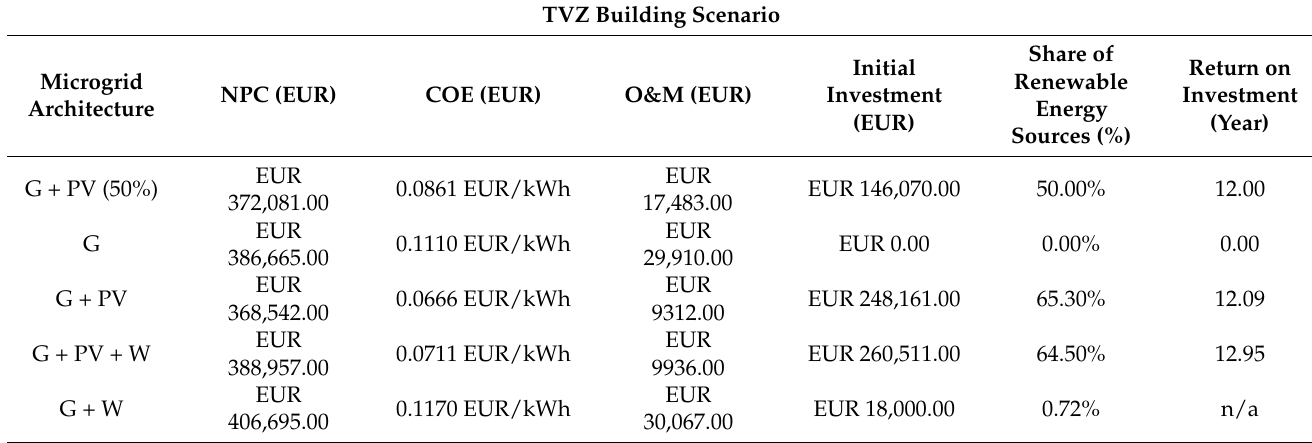
5. Evaluation of techno-economic requirements —on the basis of this, it was found that the investment return time is 12 years (Figure 9).